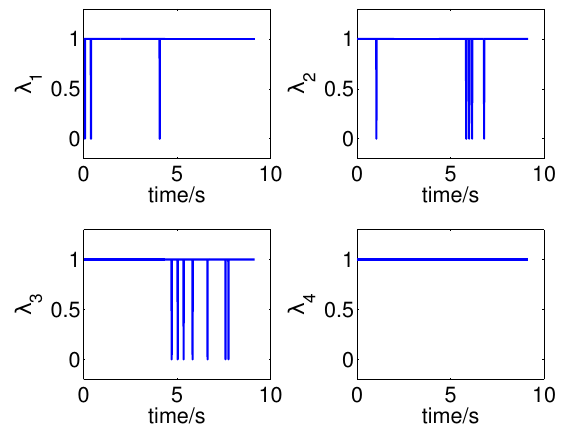
Figure 15. Parameters of jump